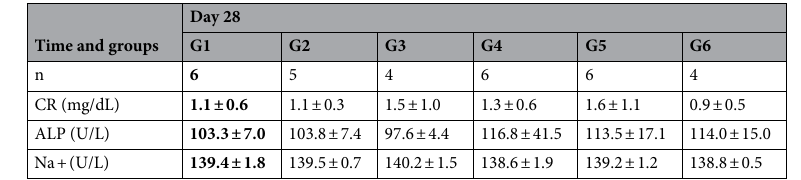
Table 4. Clinical chemistry analysis in mice treated with ConvitVax or its components in repeated doses. It is important to mention that due to the difficulty of the exsanguination procedure, in some cases an insufficient amount of sample was obtained for the complete analysis. Therefore, the number of mice was variable and is shown in the table. Abbreviations: CR creatinine, ALP alkaline phosphatase, Na + sodium.